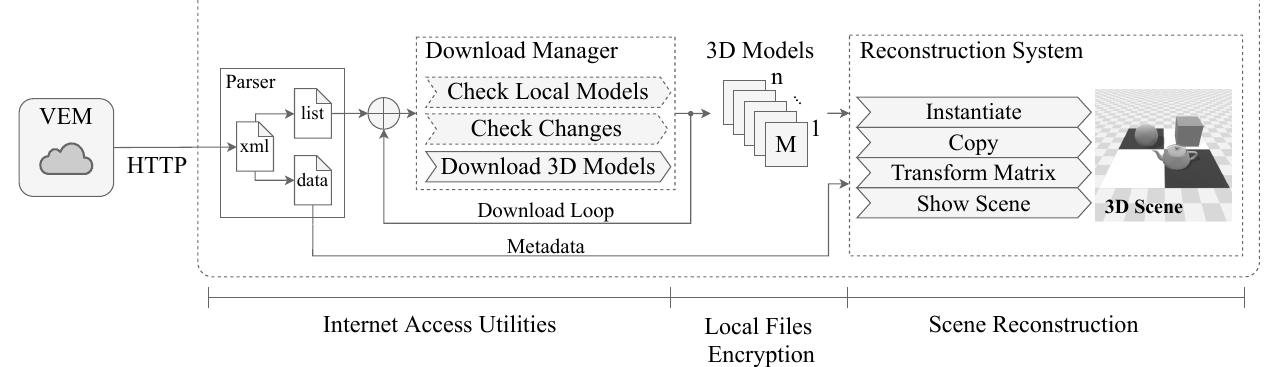
Figure 6. Conceptual diagram of the process of integration and reconstruction of the Virtual Reality software scenario.